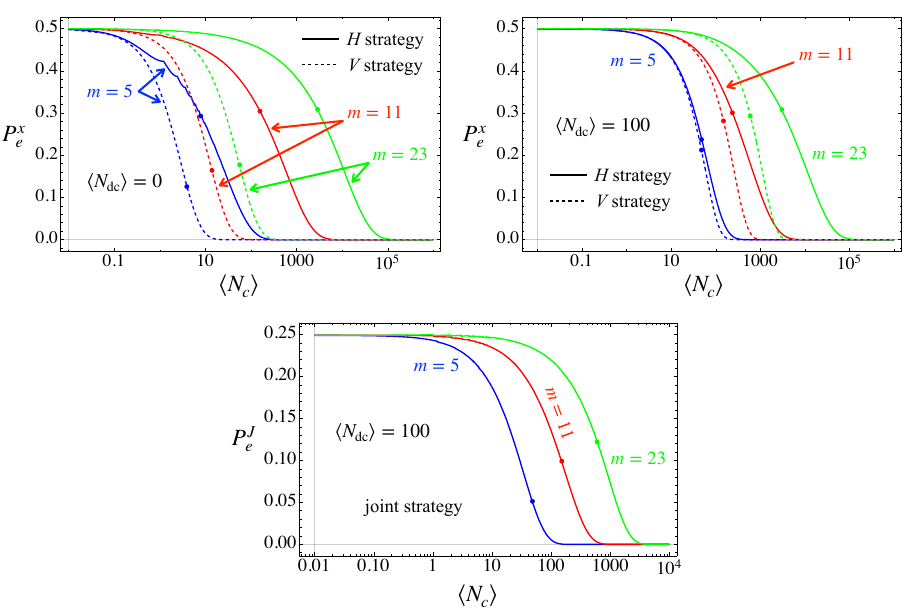
Figure 4. Probability of error for the different strategies as functions of the average num- N c ber of input photon in a semi-log plot. Red line: m = 5; blue line: m = 11; green (cid:104) (cid:105) line m = 23. ( Top panels ): H (solid lines) and V (dashed lines) strategies in the absence of dark = 100 ( right ). ( Bottom panel ): joint strategy in the case N dc counts ( left ) and for (cid:104) (cid:105) The dots on the lines refer to the threshold values evaluated according to (22) and (23). See the text for details.